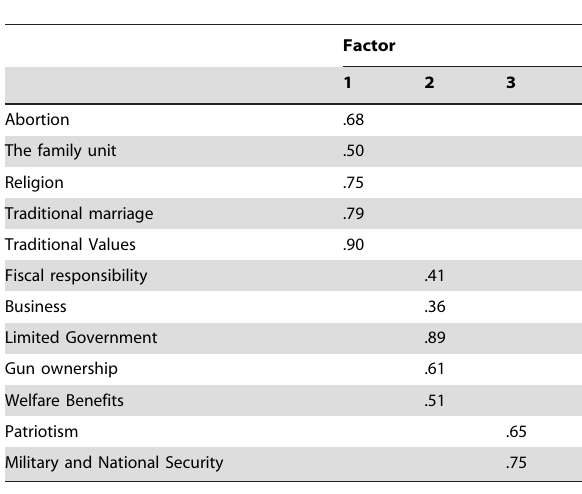
Table 2. Factor Matrix using Principal Axis Factoring (PFA) and Direct Oblimin Rotation.